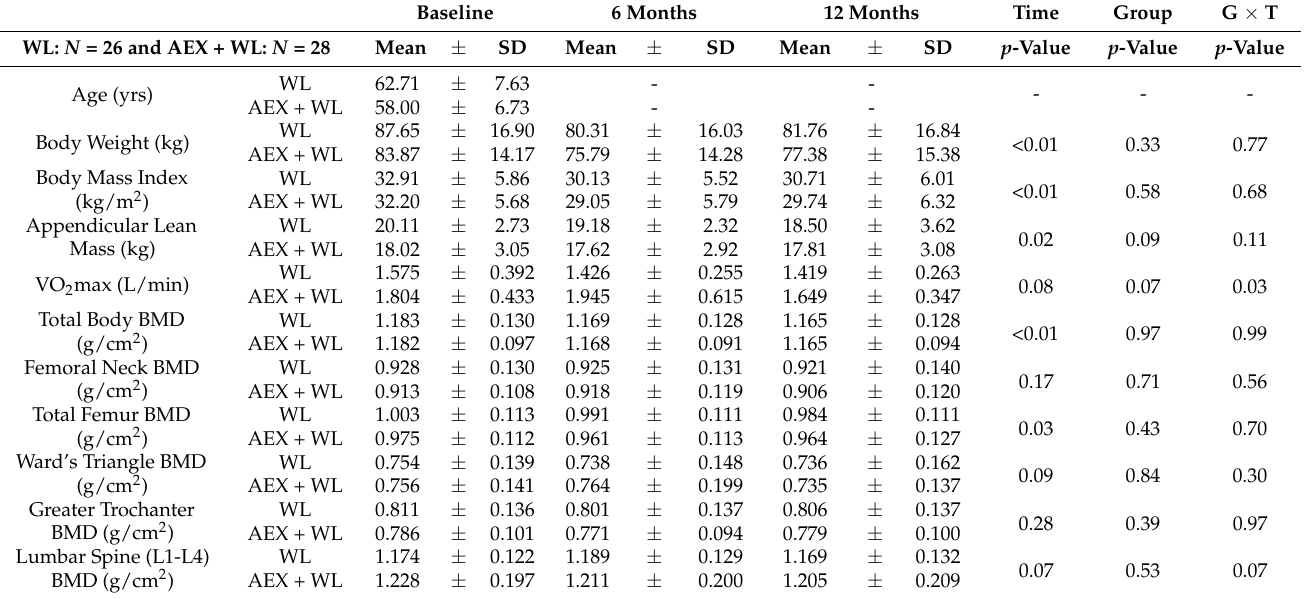
Table 1. Participant characteristics at baseline, after 6 months of weight loss with and without aerobic exercise, and after a subsequent 6 month follow